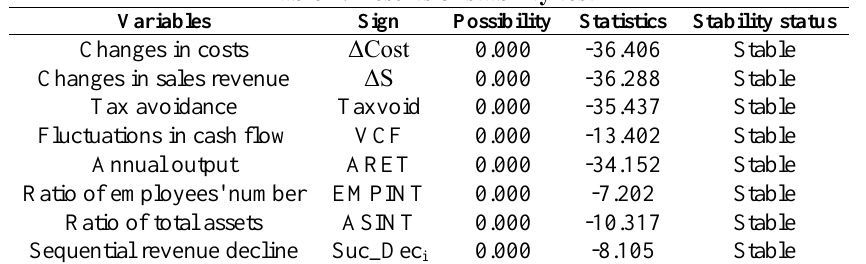
Table 2. Results of stability